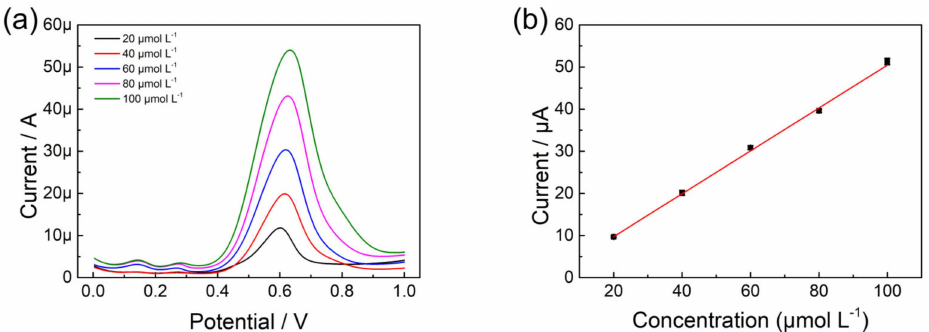
Figure 6. ( a ) The DPV of p-L-serine/CuO/CPE in different concentrations of olivetol (pH 8.0); ( b ) Plot of peak current versus concentration of olivetol. Table 1. Comparison of reported sensors for the detection of olivetol.